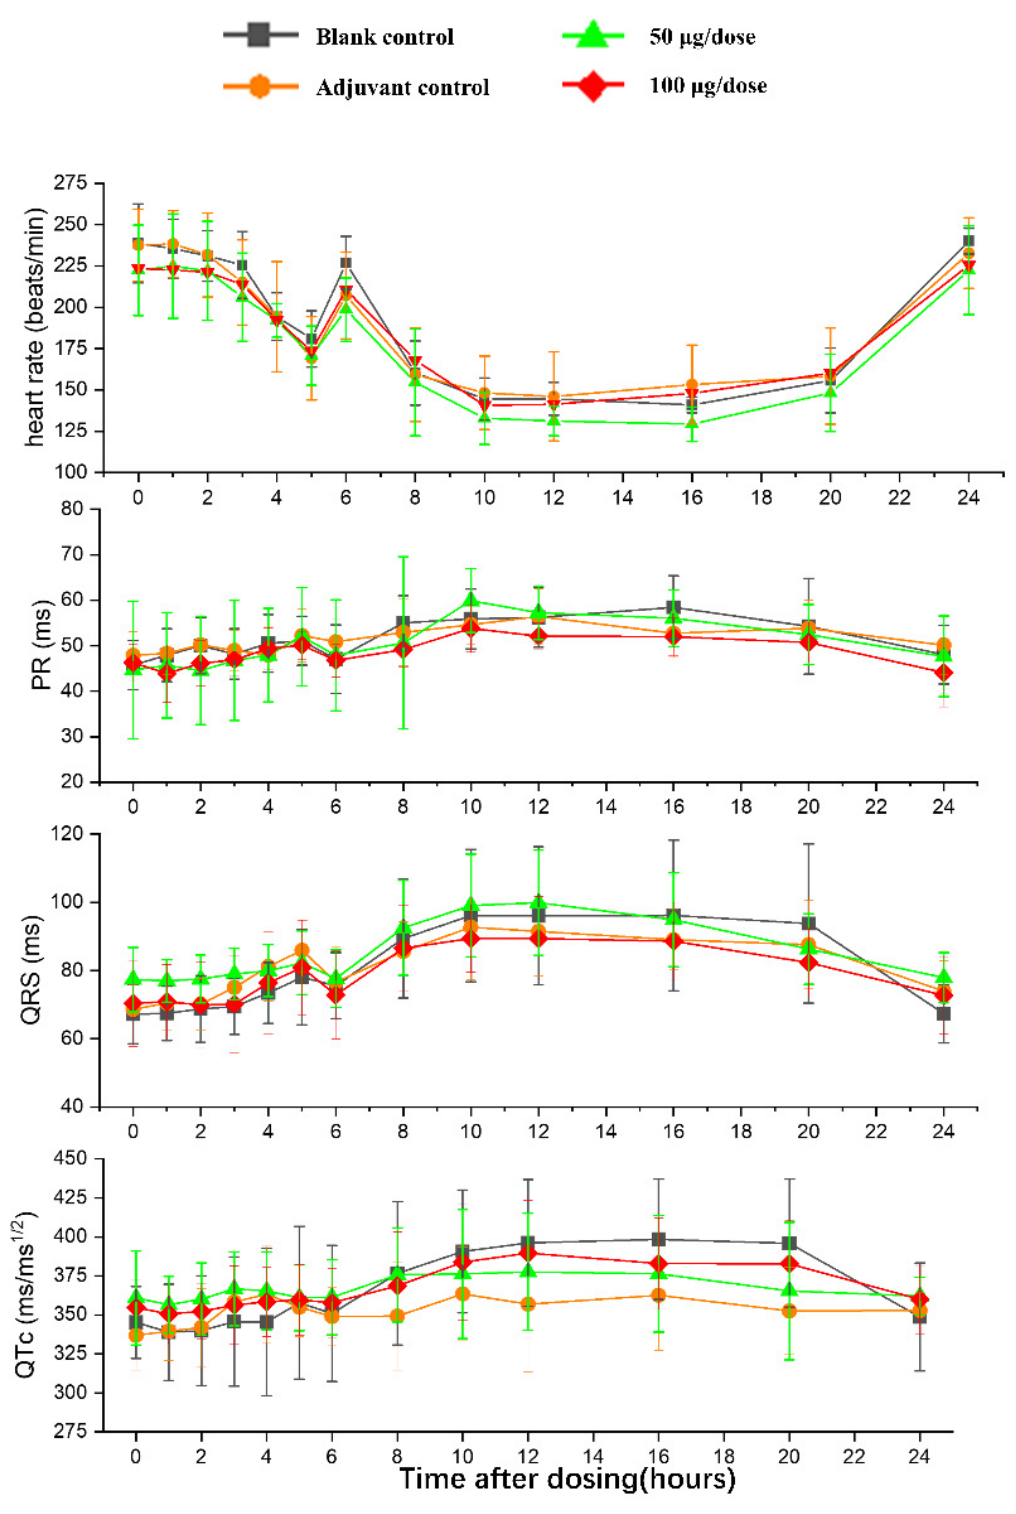
Figure 6. The effects of intramuscular injection of ZF2001 on PR, QRS and QTc in cynomolgus monkeys, n = 8 in each group. p > 0.05, vs. the blank group.